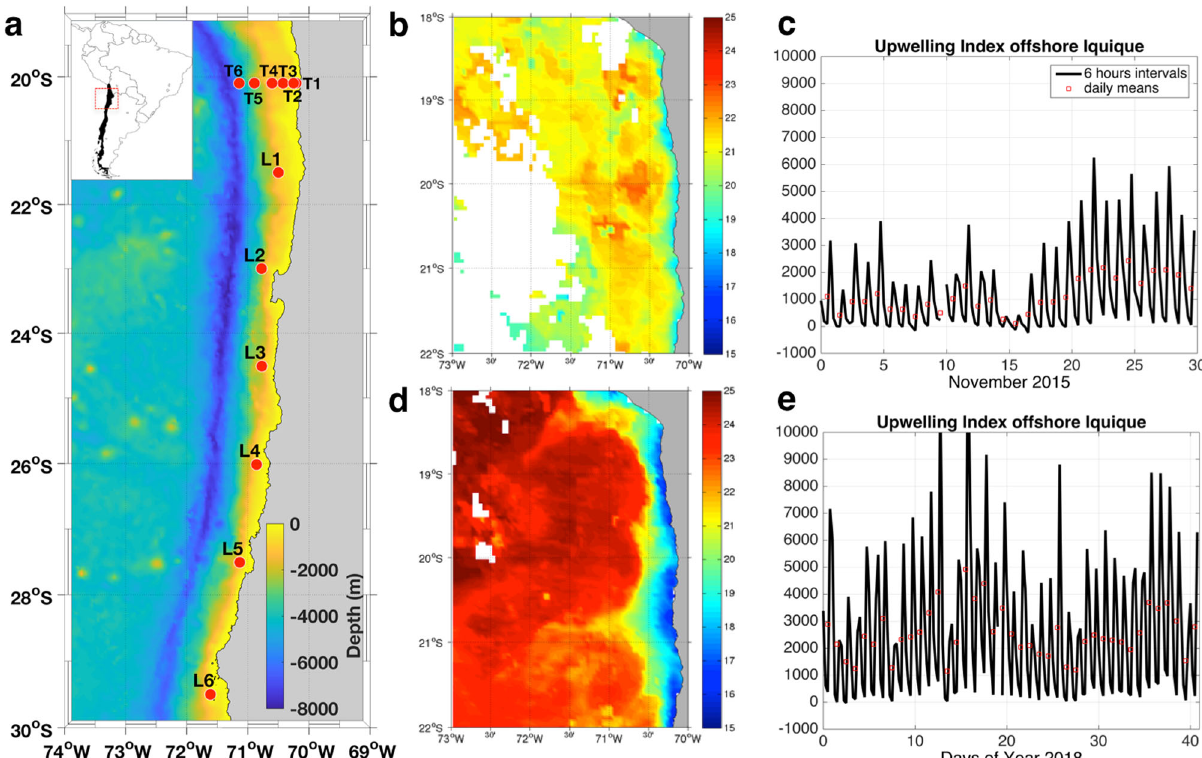
Fig. 1 Sampling stations and oceanographic conditions during the expeditions. a Study area, including six sampling stations (T1 – T6), and a longitudinal section from 20° down to 29.5°S, including six sampling stations (L1 – L6). b 25 November – 2 December 2015 composite of MODIS-Aqua SST for LowPhox I; units are in °C; persisting clouds appear in white. c Upwelling Indices for the oceanic region offshore Iquique for November 2015; black: 6-h intervals and red daily averages; units are in kgm − 1 s − 1 . d 2 – 9 February 2018 composite of MODIS-Agua SST for LowPhox II; units are in °C; persisting clouds appear in white. e Upwelling index for the oceanic region offshore Iquique from 1 January to 12 February 2018; the black lines are 6-h intervals and red dots correspond to daily averages; units are in kgm − 1 s − 1